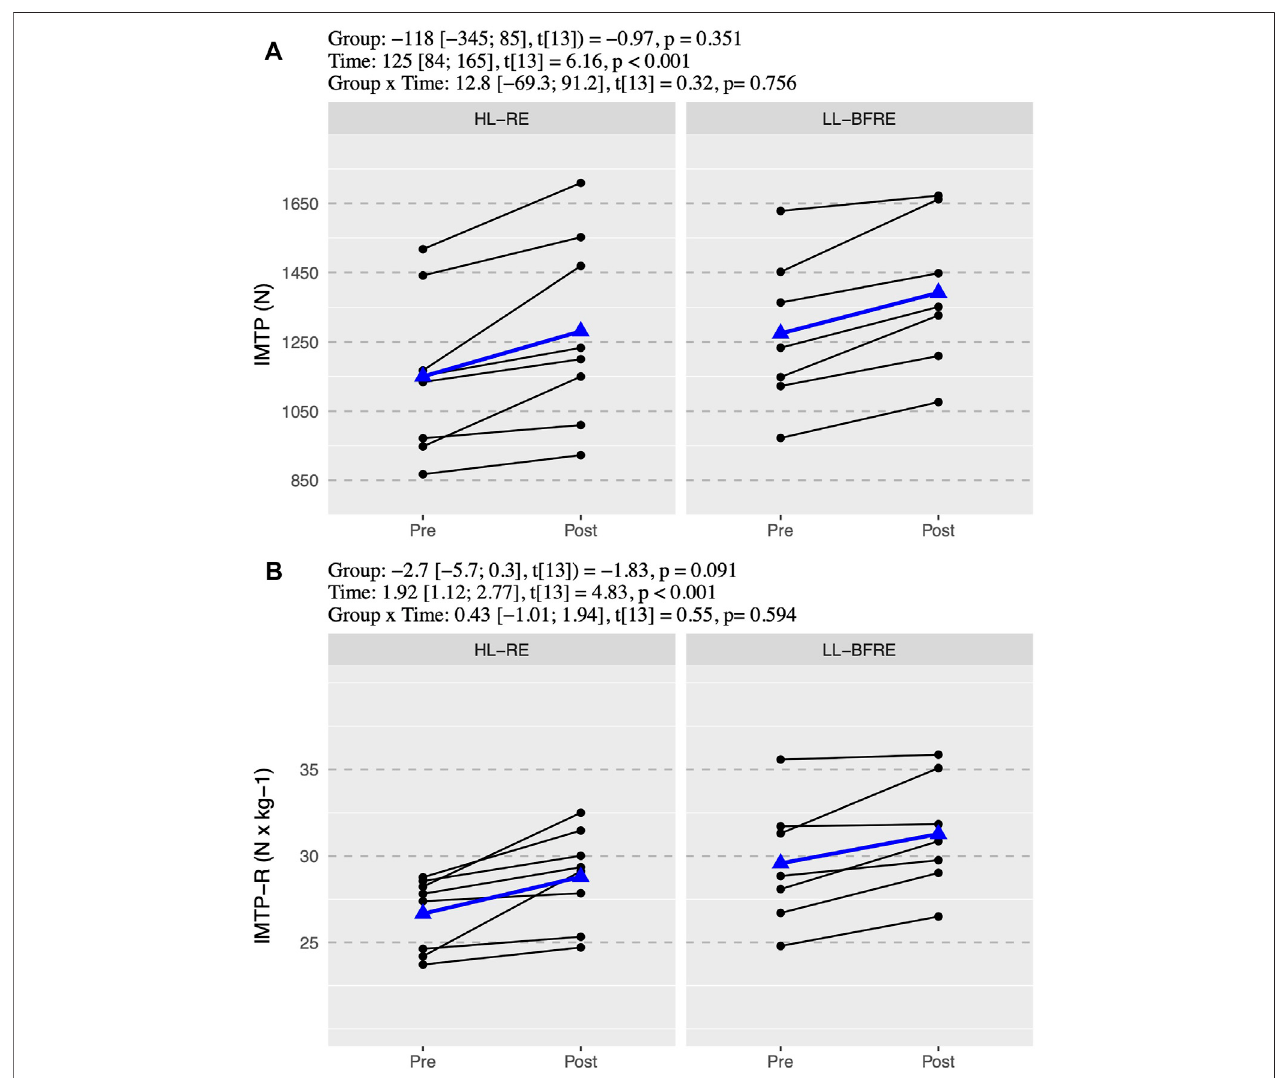
FIGURE3| Absolute (A) andrelativeisometricmid-thighpull (B) .Blackpointsandlinesrepresentindividualresponses.Bluetrianglesandregressionlinerepresent the mean response. Effects of the group (HL-RE vs. LL-BFRE), time (POST vs. PRE) and interaction (HL-RE vs. LLBFRE * POST vs. PRE) are presented through beta coef fi cient and 95% of the con fi dence interval, t-value and p -value obtained after mixed model analysis. HL-RE: high-load exercises group; LL-BFRE: low-load blood fl ow restriction exercise group; IMTP: isometric mid-thigh pull; IMTP-R: isometric mid-thigh pull relative to bodyweight.